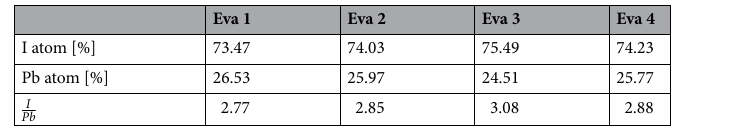
Table 1. EDX measurement of the absorbers from different evaporation processes. The atomic fractions were normalized to 100%. A relative error of 4% for all measurements was considered as reasonable and calculated by the EDX software.